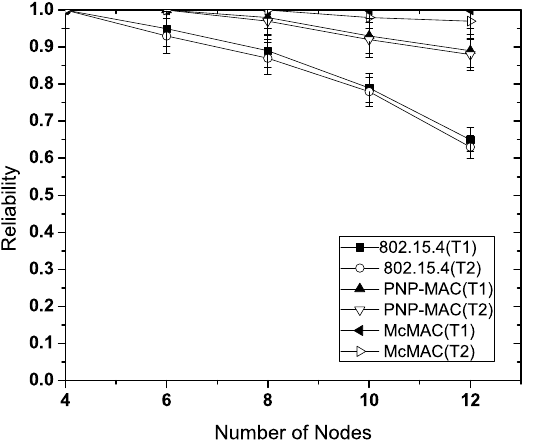
Figure 9. Reliability at varying number of nodes without emergency traffic.